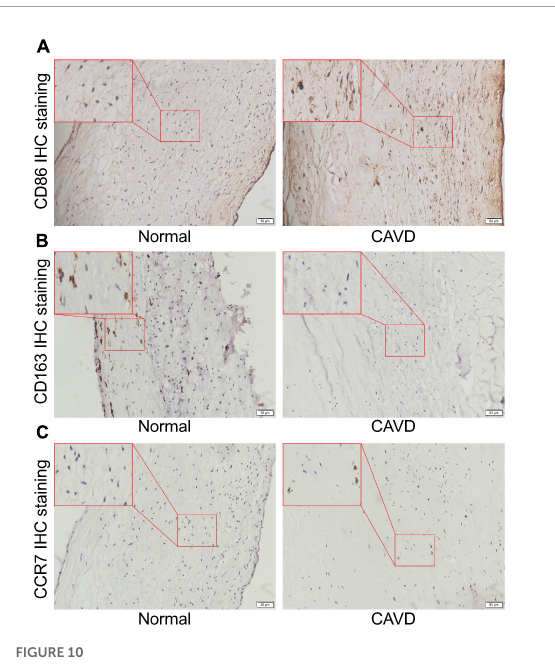
FIGURE10 Representative IHC staining images. (A) Representative CD86 IHC staining images of normal aortic valve tissue and calcified aortic valve tissue. (B) Representative CD163 IHC staining images of normal aortic valve tissue and calcified aortic valve tissue. (C) Representative CCR7 IHC staining images of normal aortic valve tissue and calcified aortic valve